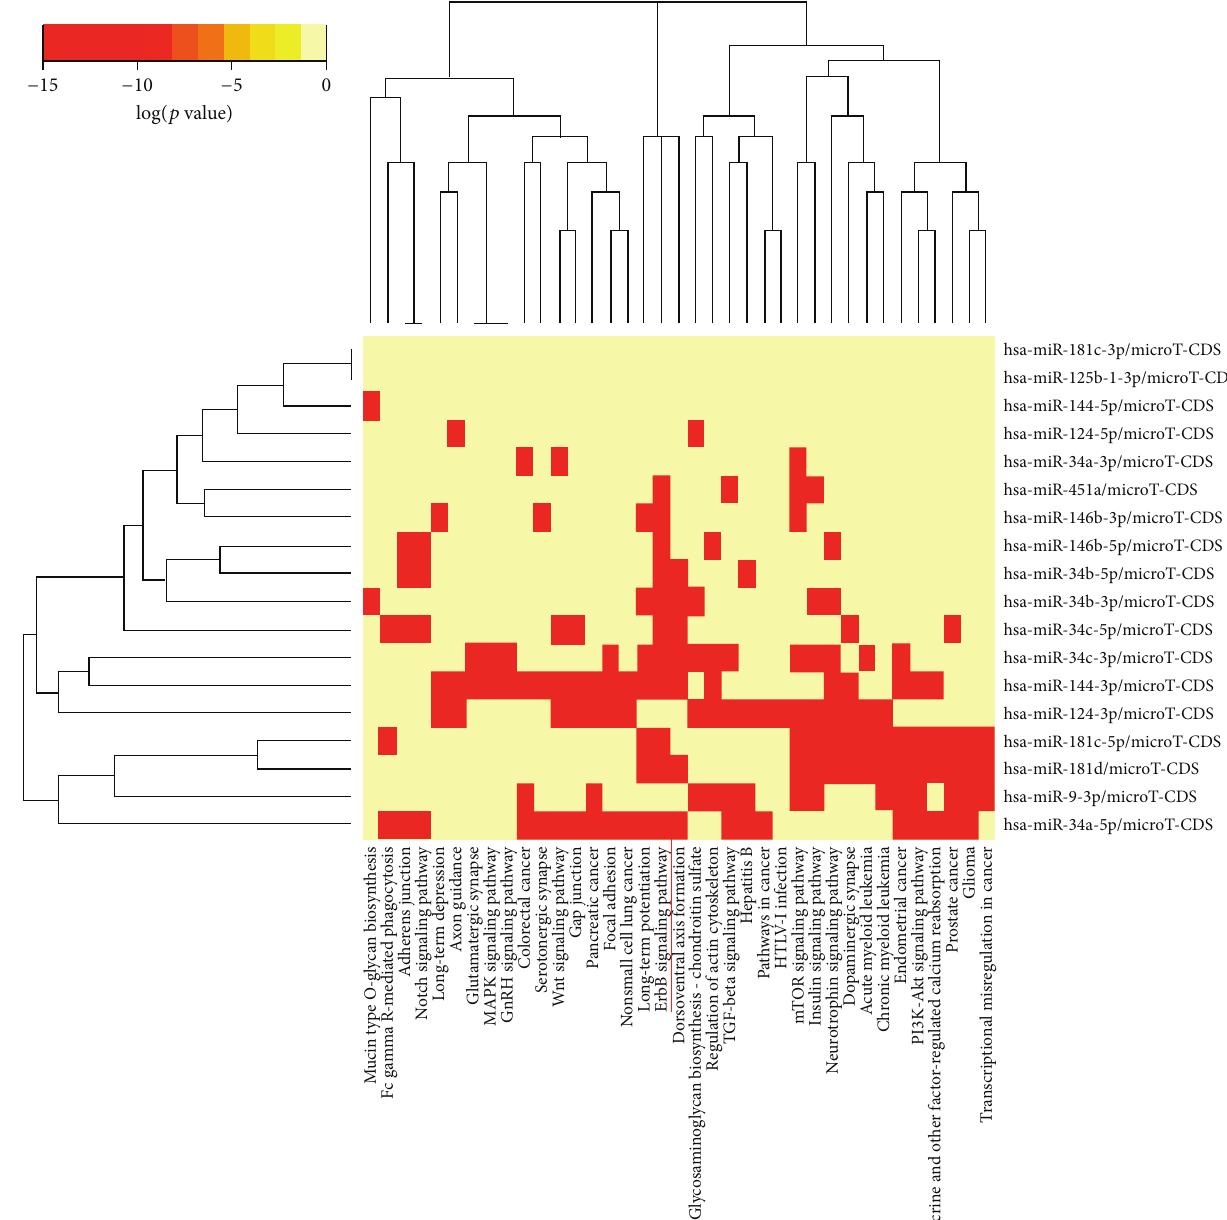
Figure 3: Heat map of hypermethylated microRNAs versus predicted target pathways. The figure illustrates hierarchical clustering results for miRNAs ( 𝑦 -axis) and pathways ( 𝑥 -axis). The neuregulin receptor complex (ErbB) signaling pathway is clearly targeted by most investigated miRNAs. Image derived from DNA Intelligent Analysis- (DIANA-) miRPath using microT-CDS as the target prediction algorithm.